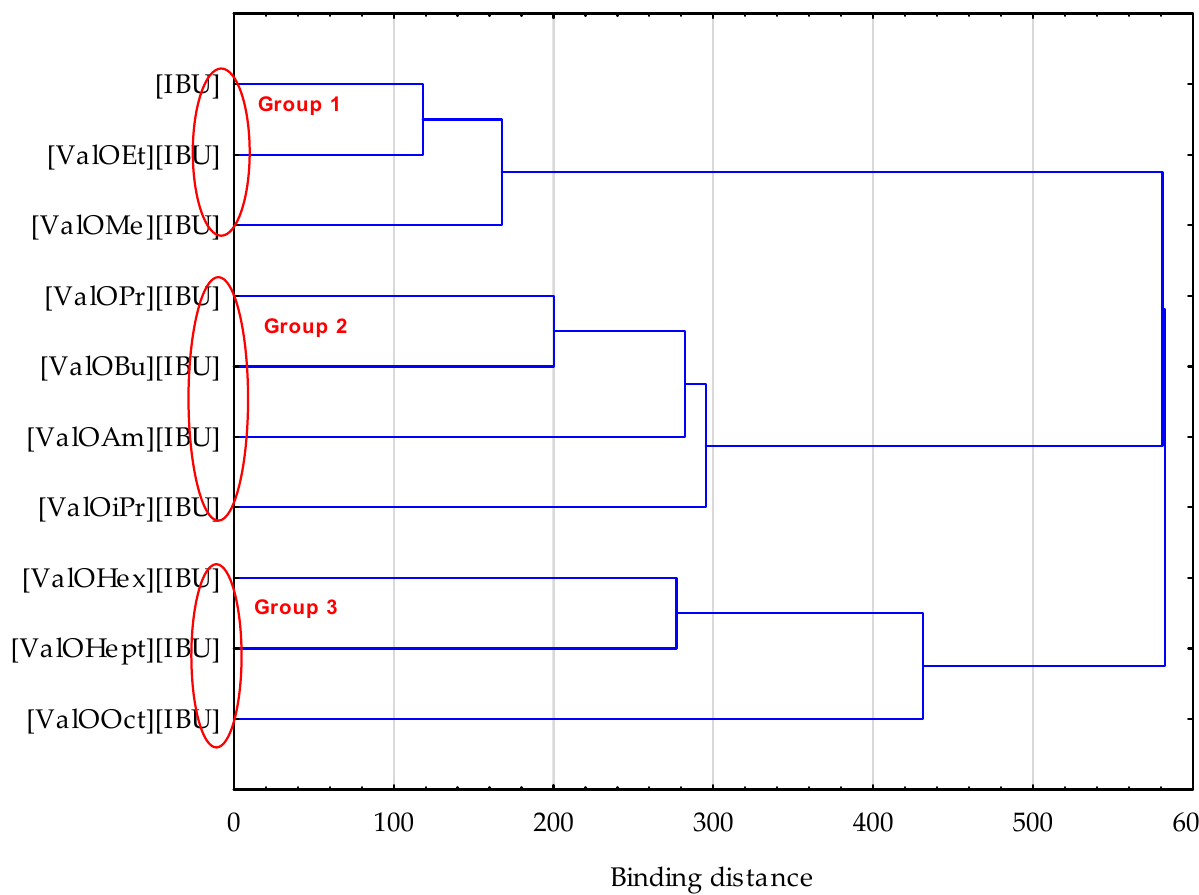
Figure 3. Cluster analysis plot for average cumulative mass for IBU and its derivatives permeated across human skin and Strat-M ® .